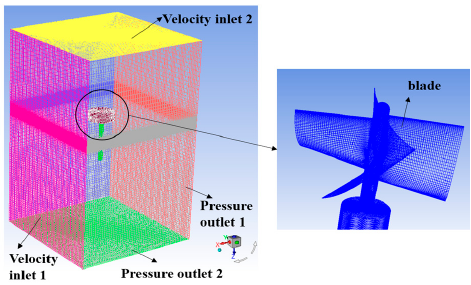
Figure 5. Meshing and boundary conditions. Table 1. Analysis conditions.